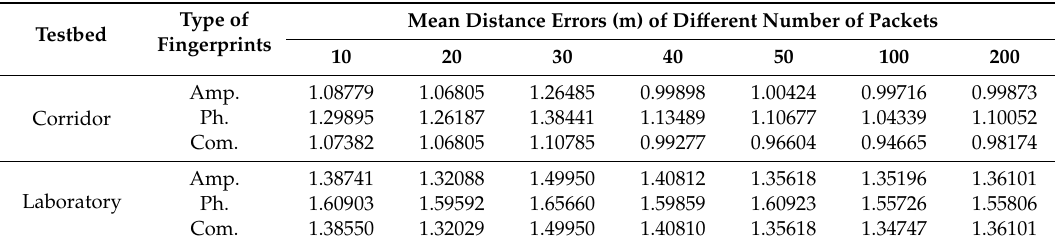
Table 4. Mean distance errors using di ff erent number of packets.